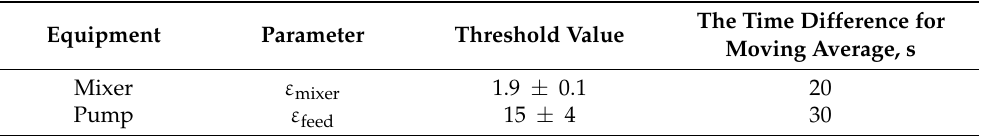
Table 1. Threshold values to trigger the alert system for mixer and feed addition pump malfunctions. Averaged values obtained from multiple experiments with their standard deviation are reported.